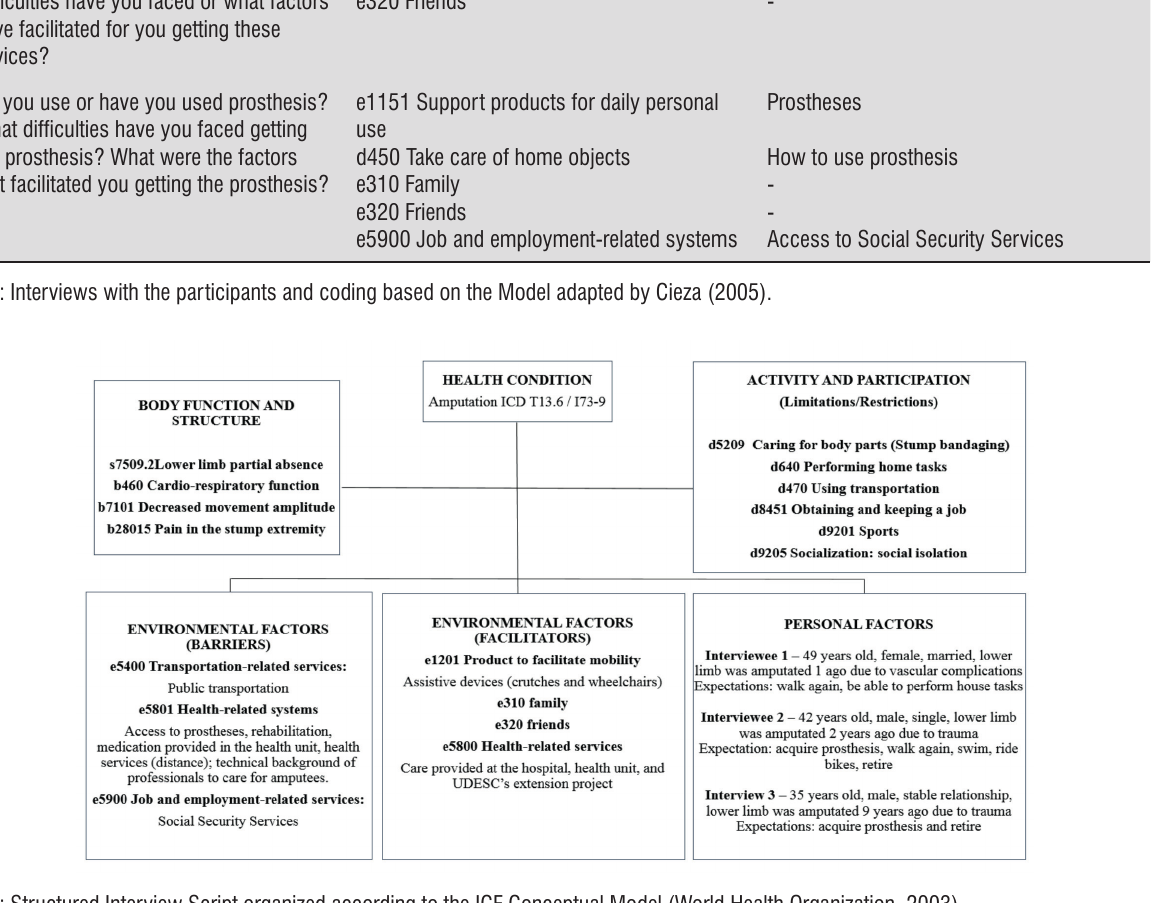
Figure 1 - ICF Conceptual Interaction Model – Amputees who do not use